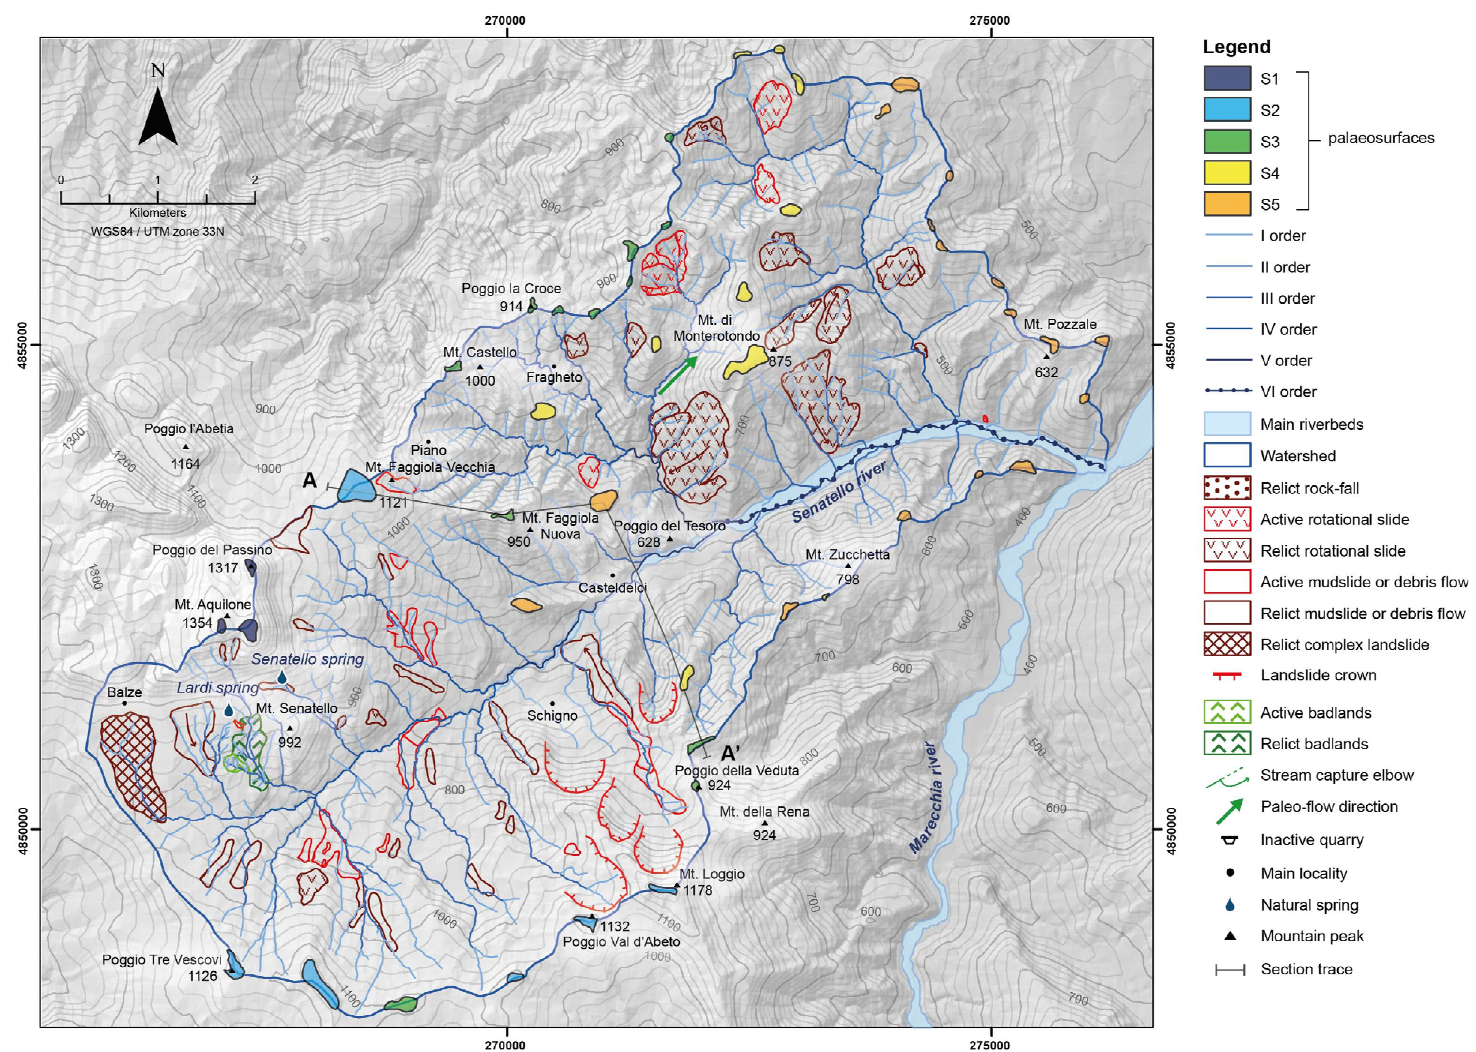
Figure 7. Geomorphological map of Senatello river valley.